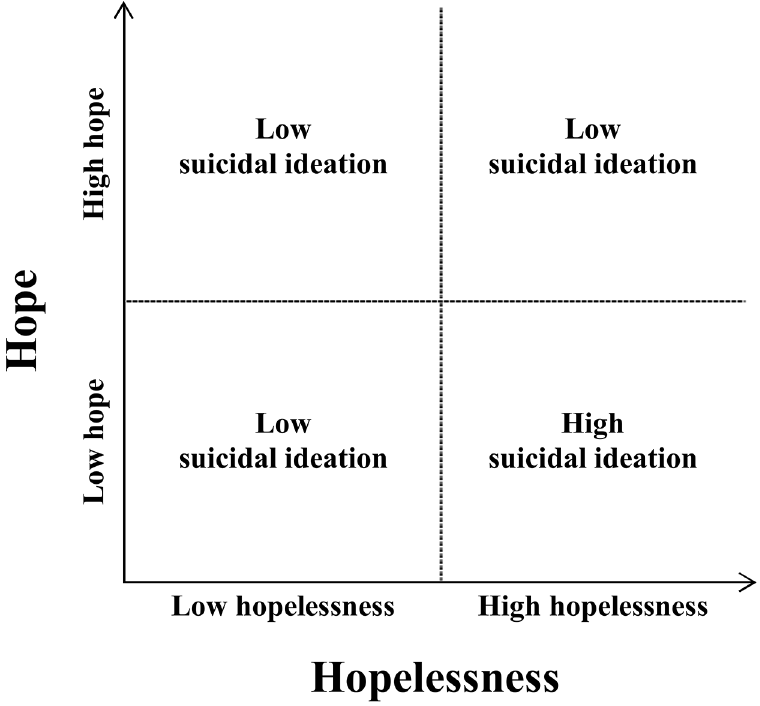
Fig 2. Interaction between Hope and Hopelessness within the Context of Suicidal